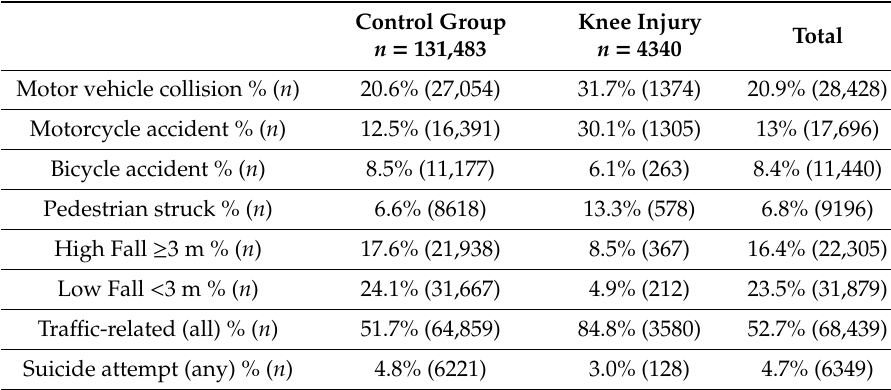
Table 1. Mechanisms of injury.